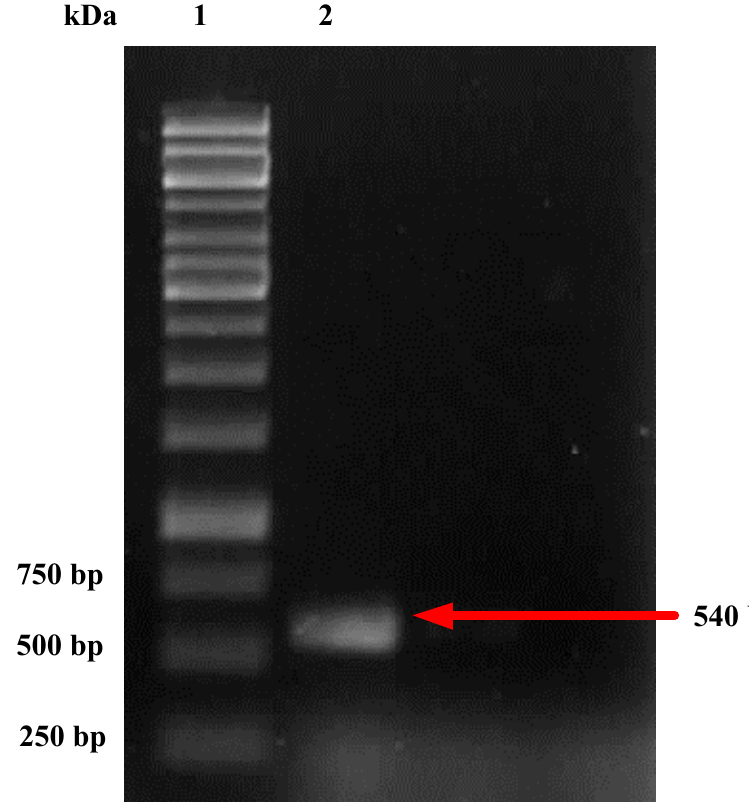
Figure 2. PCR amplification of genomic DNA of P. citrinum (lane 2) on agarose gel 1%. Lane 1—DNA size marker.